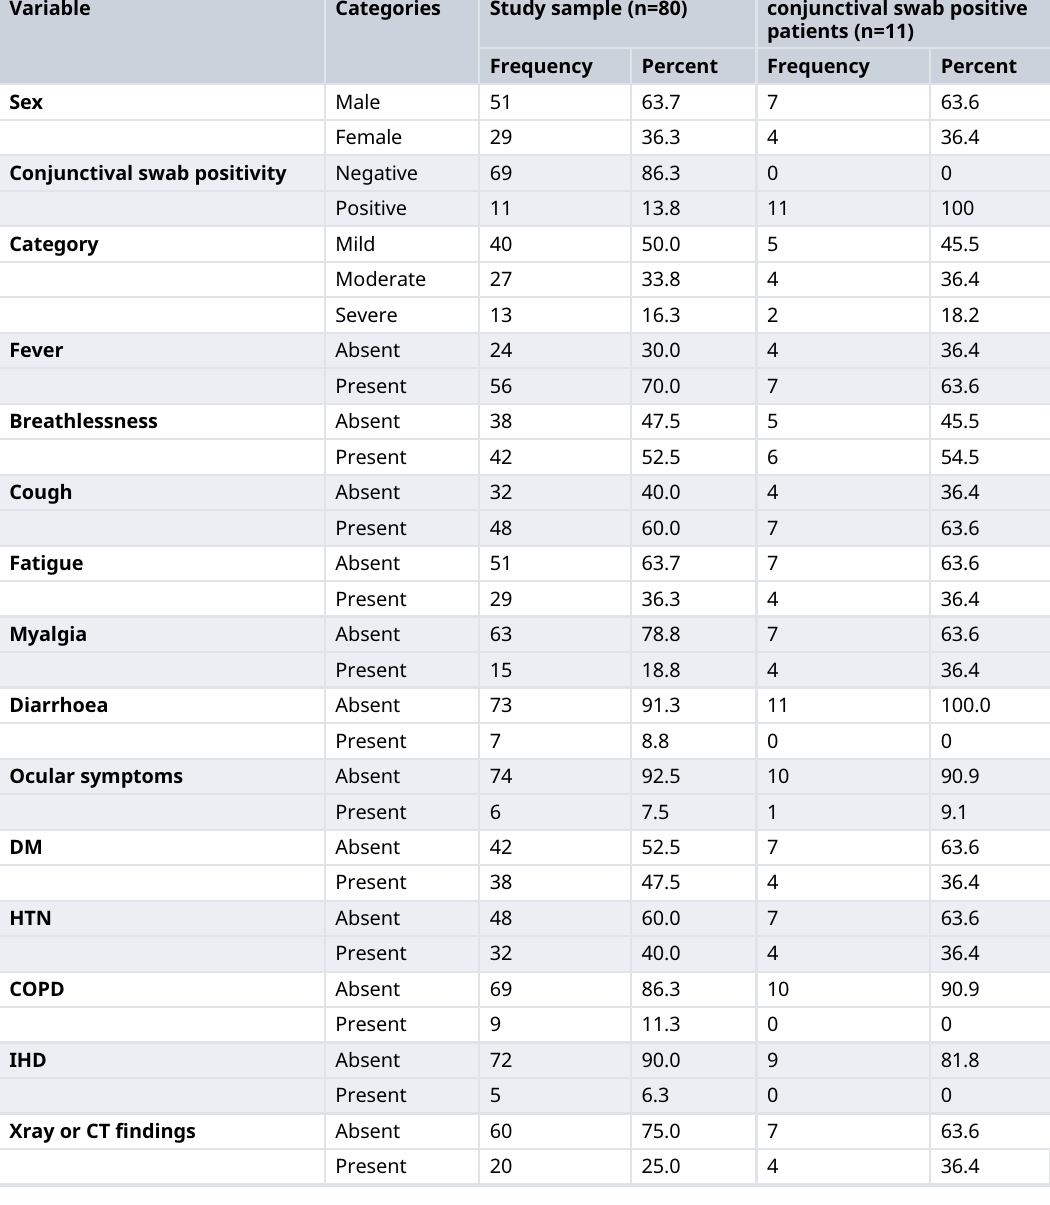
Table 2. Descriptive statistics for categorical variables for the whole sample and conjunctival swab positive patients.